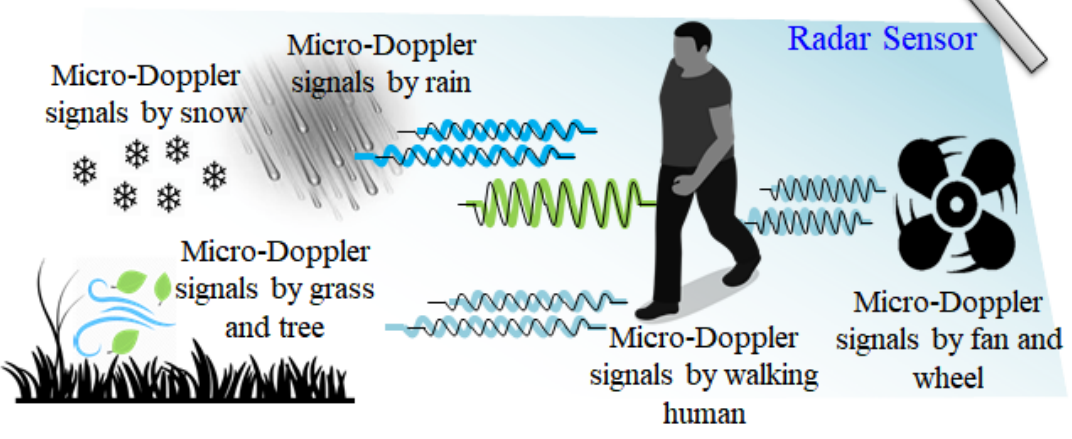
Figure 1. The difficulties of recognizing human walking by micro-Doppler signals. The background noise should also be considered when detecting human walking on the ground. Also, recognizing background noise can provide useful